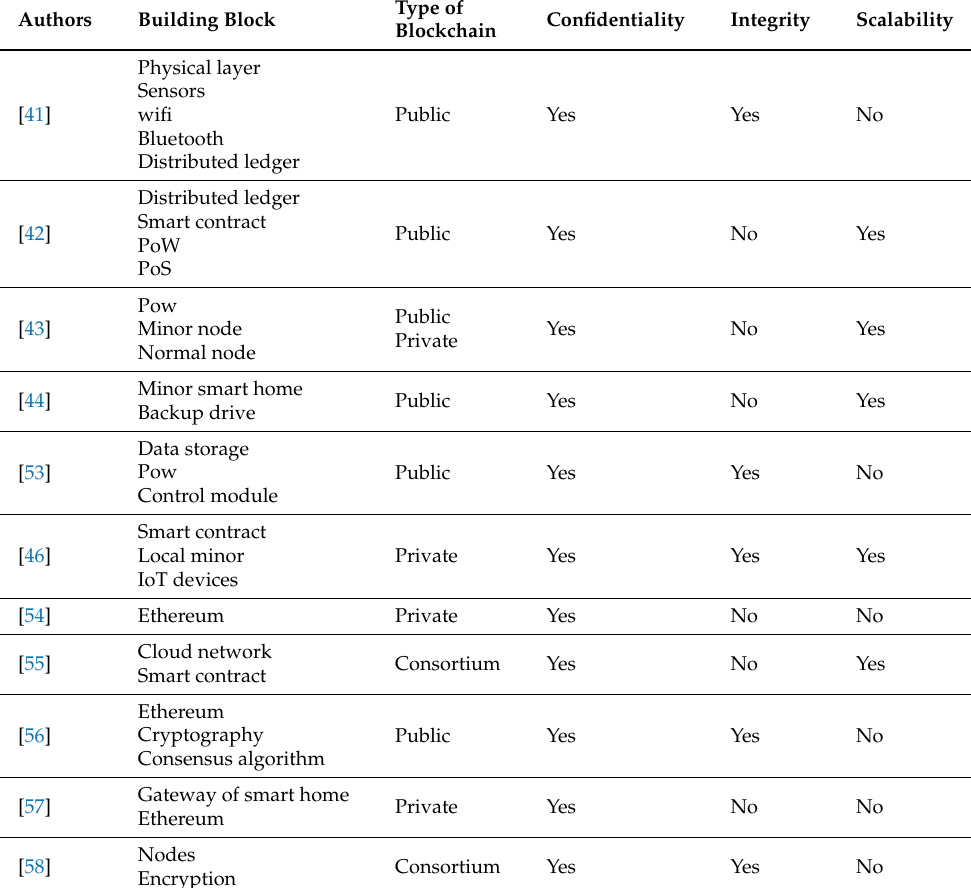
Table 1. Smart home blockchain-based architecture existing